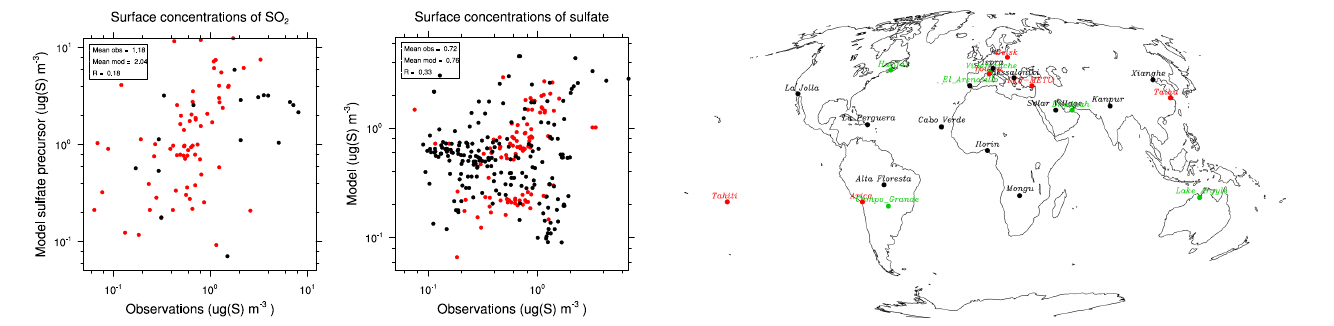
Figure 11. Scatter plot of observations (EBAS database, see text) and corresponding NudSimd2_Trans output: mean annual surface concentrations (2005) of (left) observed SO 2 ( µ g(S) m − 3 ) and modelled sulfate precursor, (right) sulfate ( µ g(S) m − 3 ). Red dots are mostly for European sites, while black dots are for US sites. Means of all observations, all model output and correlation coefficients (R) are shown.